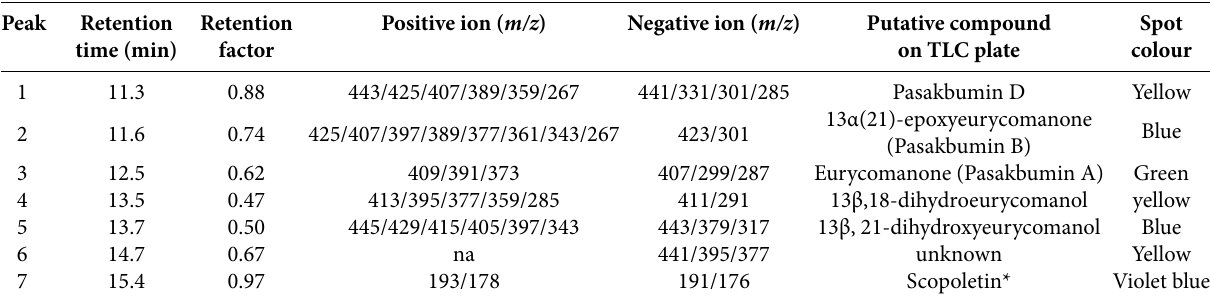
Chua et al.: Identification of Phytochemicals from ...